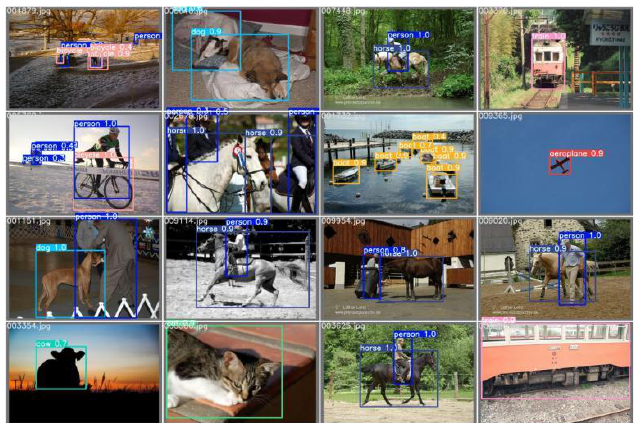
Figure 8. The detection effect of the algorithm.